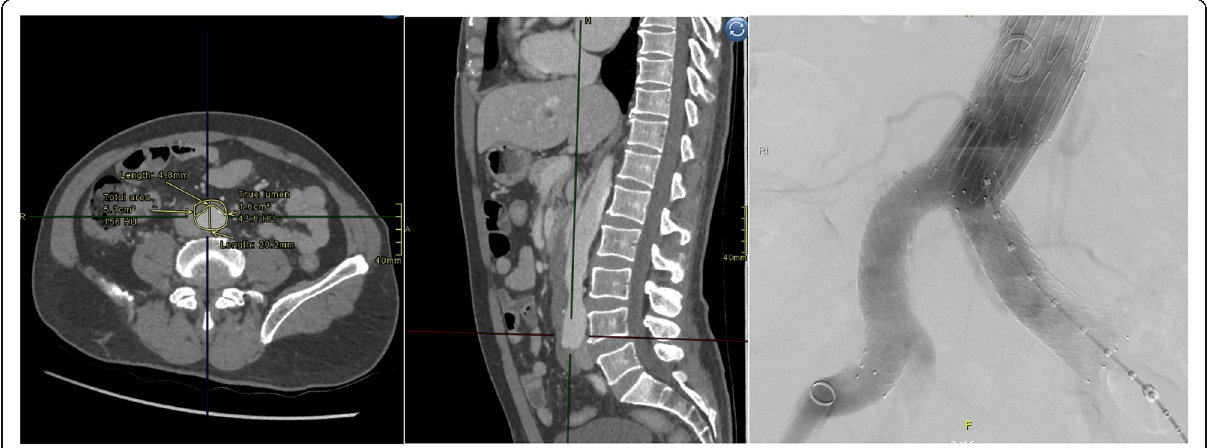
Fig. 3 MPR at the level of the aortic bifurcation. Bilateral iliac stents have been deployed to correct iliac dissection, captured during stent